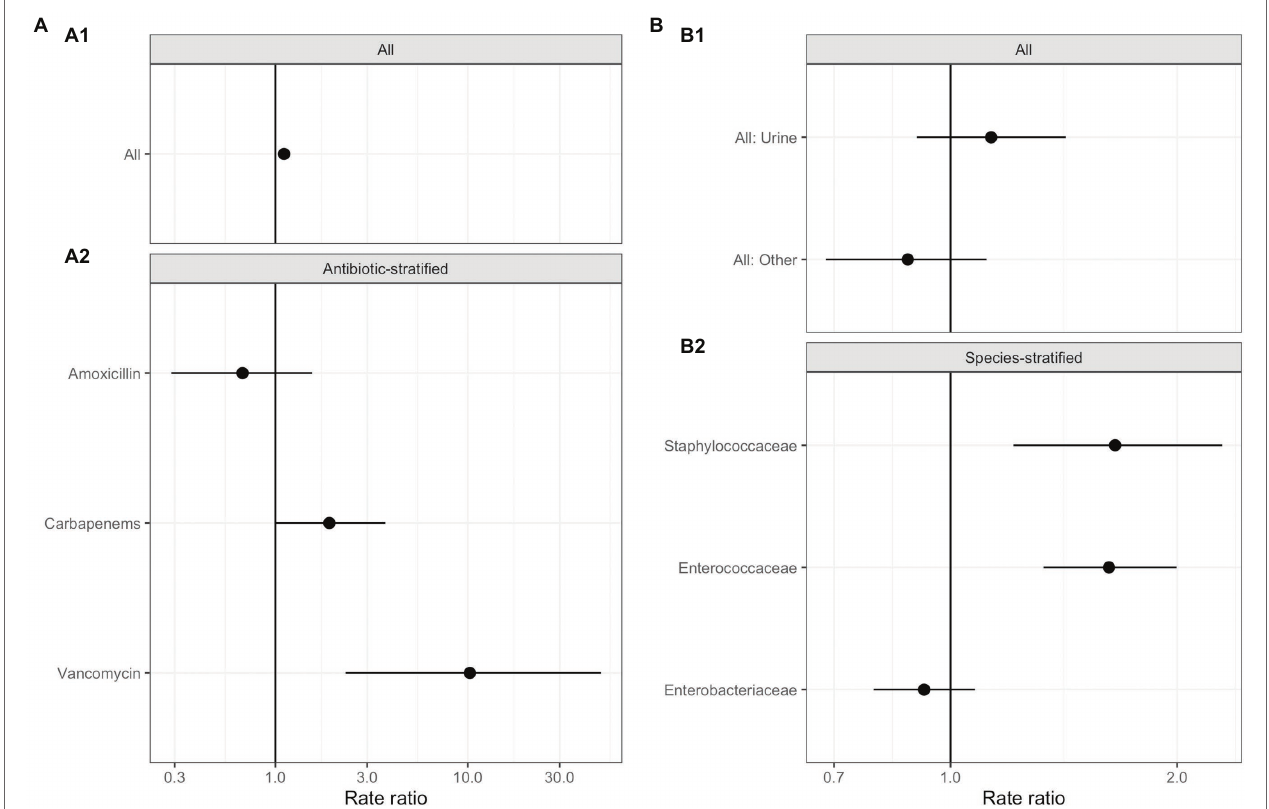
FIGURE 3 | Generalized linear mixed effects models for the relationship between antimicrobial resistance gene abundance, hospital department antibiotic consumption rates, and hospital department rates of resistance in clinical isolates. (A) Effect of antimicrobial usage (AMU) measured in defined daily dose per 100 occupied bed days (DDD/100 OBDs) on ARG abundance. (A1) The main model, with a single coefficient for all resistance phenotypes. (A2) Separate models with coefficients for each antimicrobial. (B) Association between antimicrobial resistance gene abundance in the sewage and clinical resistance rates. (B1) Main model, with a single coefficient for all clinical isolate taxonomic family, stratified by sample type – urine or fecal samples (All: Urine), and for resistance genes and any other sample source (All: Other). (B2) Separate models with coefficients for each isolate taxonomic